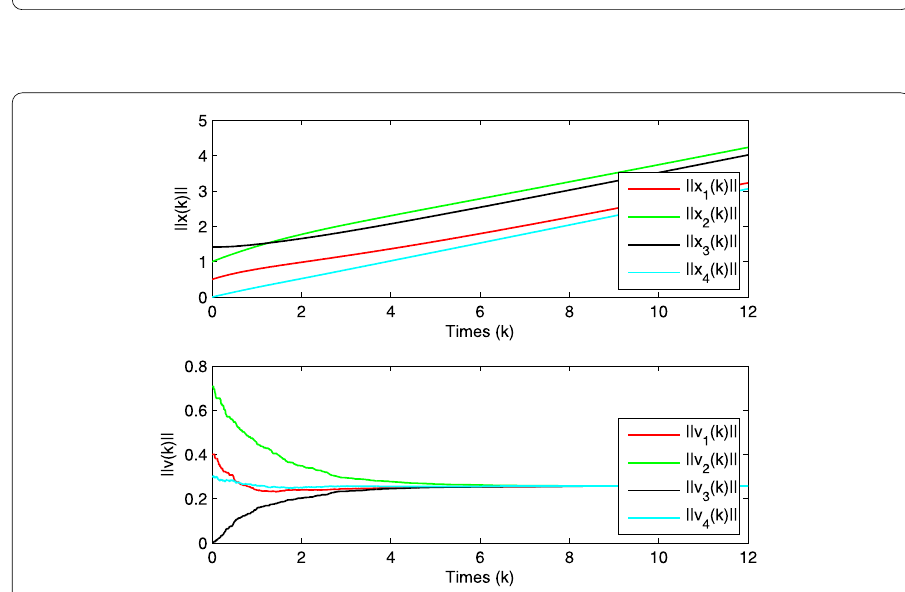
Figure 10 The norms of position and velocity trajectories with α = 1.2 in Case